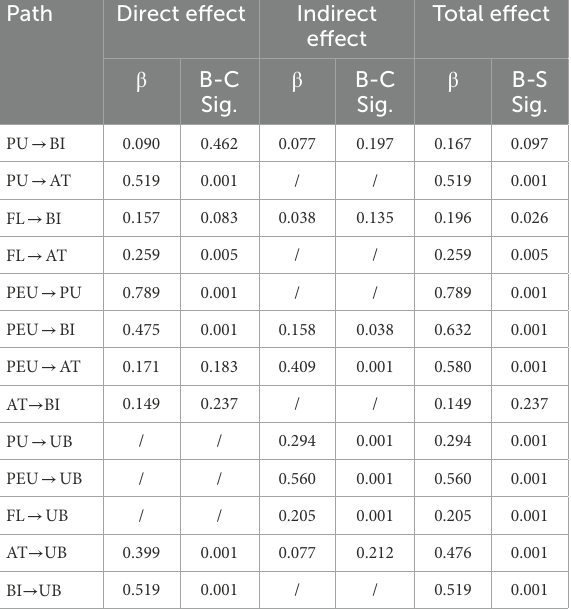
TABLE 12 Direct and indirect effects.